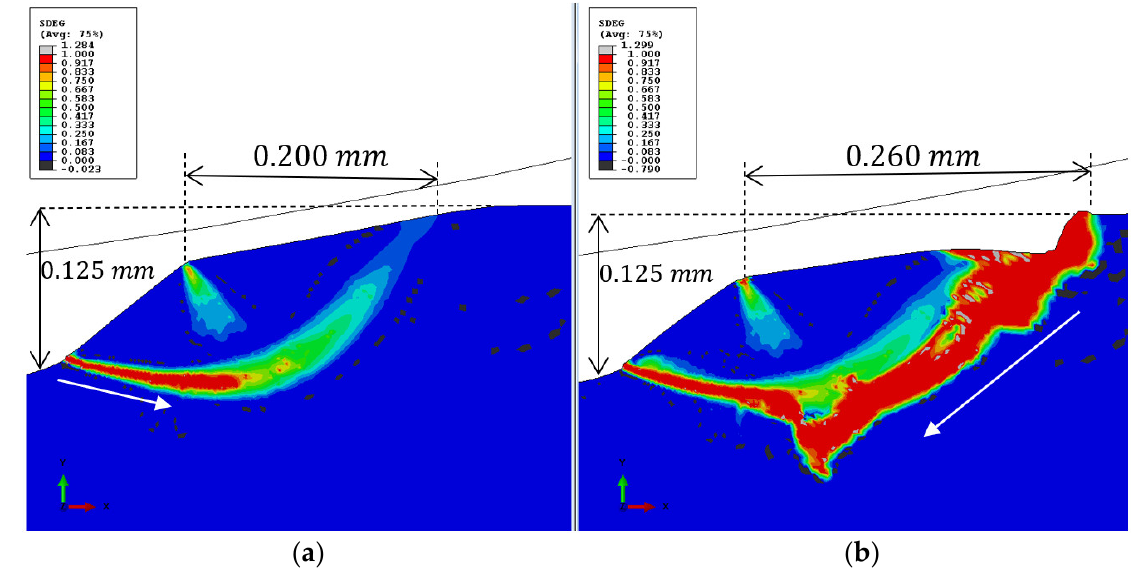
Figure 15. Simulation results of parameter D , using the accumulated inelastic hysteresis energy CDM model. ( a ) Presence of only a sub-surface crack at the spall edge, ( b ) appearance of surface cracks after changing the pressure distribution at the spall edge.